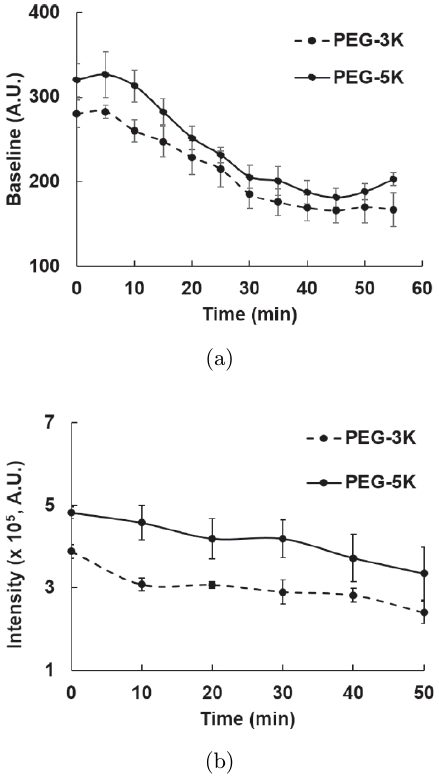
Fig. 12. Dynamics of peak width for PEG-3 K and PEG-5 K nanoparticle aggregates measured by IVFC ð n ¼ 3 Þ .